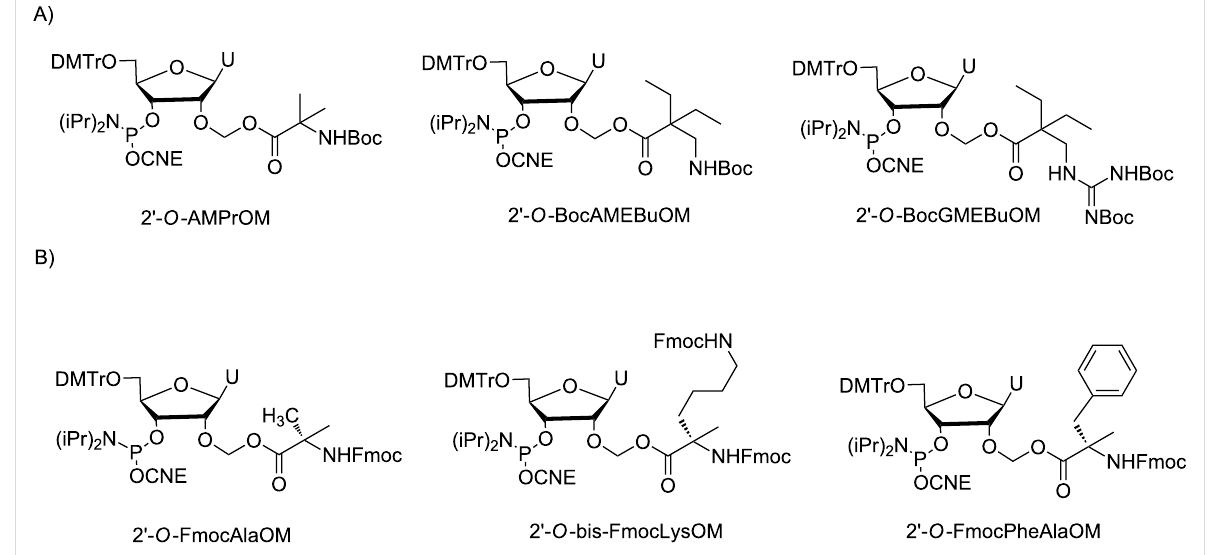
Figure 3: A) 2’- O -amino and guanidino-containing acetal ester phosphoramidites and B) 2’- O -(amino acid) acetal ester phosphoramidites reported by Debart [54] and Dahma [55], respectively.